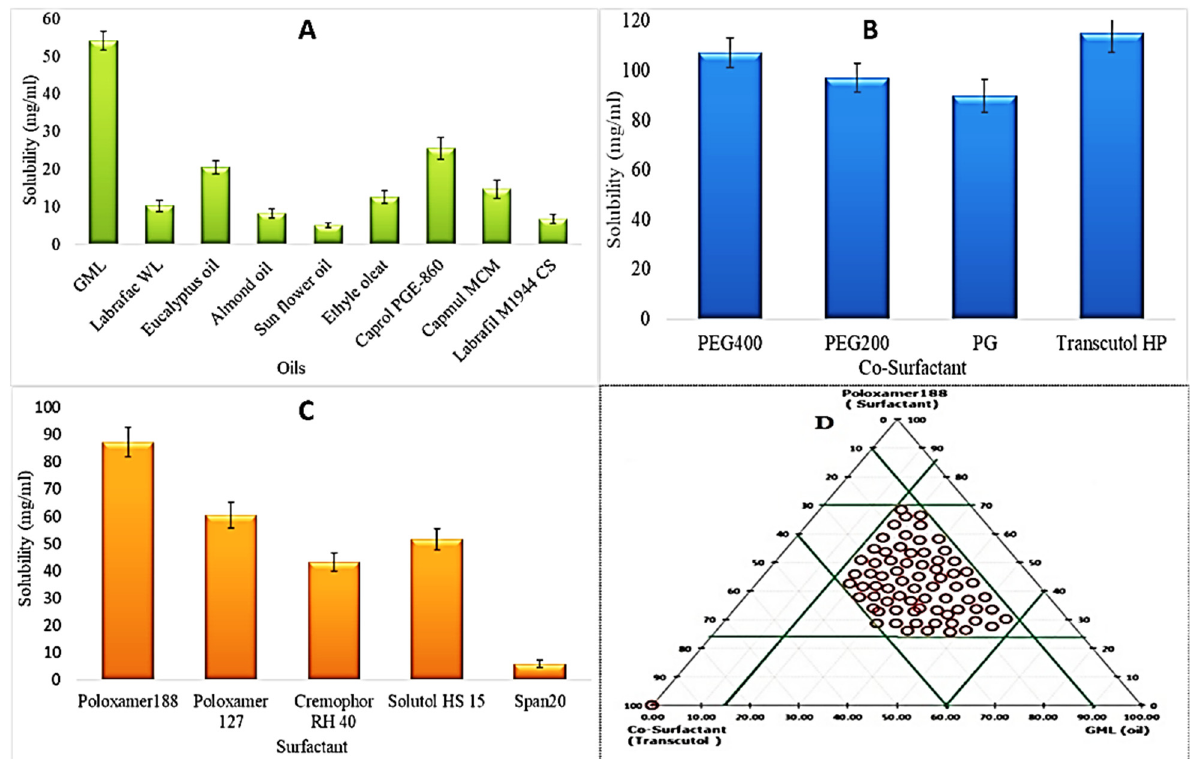
Figure 1. ( A – D ): Showing the solubility behavior of PE in various vehicles like surfactant ( A ), co-surfactants ( B ), and oils ( C ). Ternary phase diagram of PE SNEDDS formulation ( D ). Red covered area in ternary phase diagram represents the experimental domains for BBD. Values are given as mean ± SD ( n = 3).